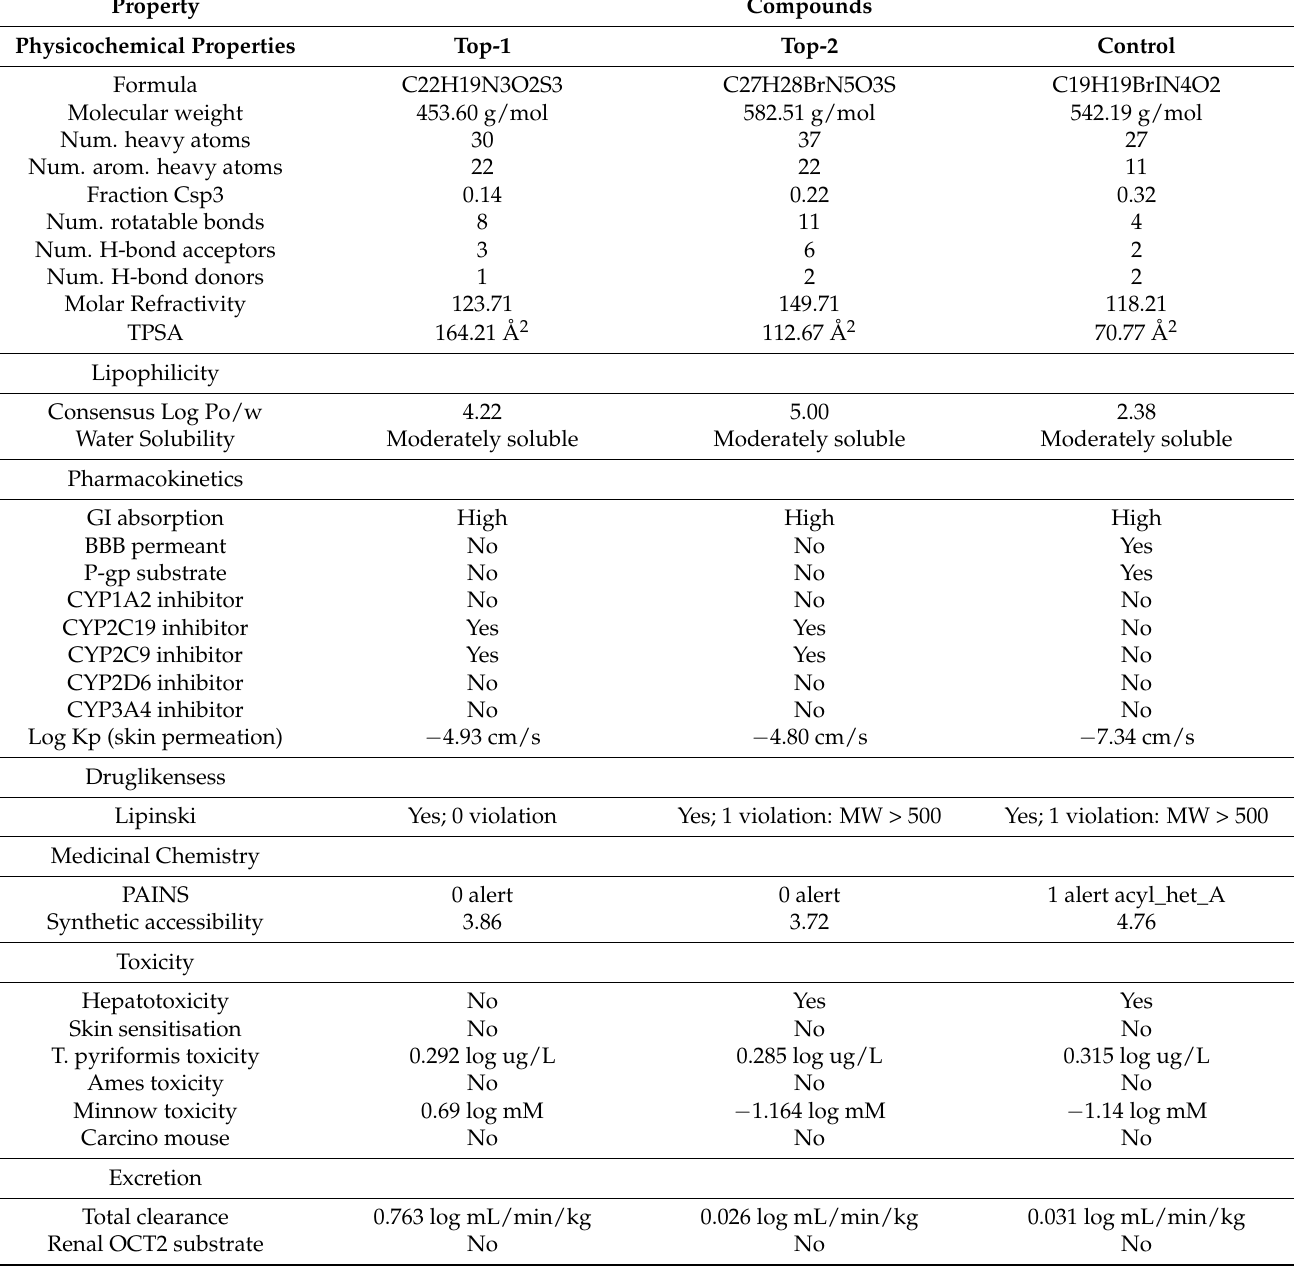
Table 4. Computational pharmacokinetics along with several pharmaceutically important parameters of the compounds. Property Compounds Physicochemical